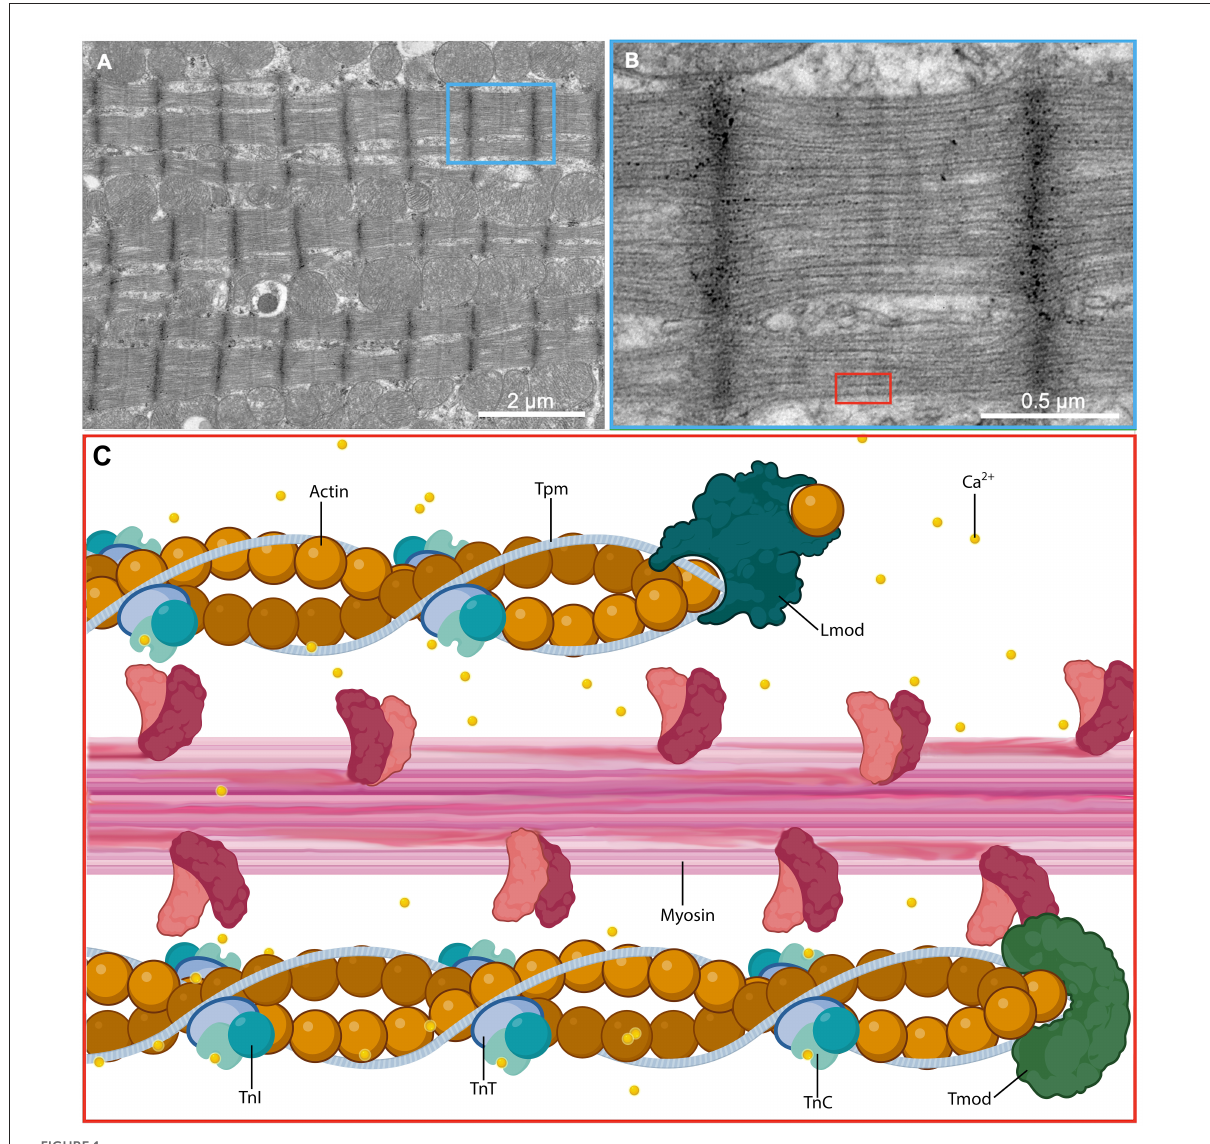
FIGURE1 Molecular structure of the cardiac sarcomere. (A) Low and (B) high magnification electron micrographs showing the sarcomeres of a cardiac myocyte in a glutaraldehyde-fixed heart from an adult male C57BL/6 mouse. (C) A magnified schematic illustrating the molecular ultrastructure of the sarcomere and demonstrating the interaction between thick filaments that act as the motor apparatus of the cell and drive contraction and thin filaments that regulate the actions of the thick filaments in response to calcium flux. Ca 2 + , calcium ion; TnC, troponin C; TnI, troponin I; TnT, troponin